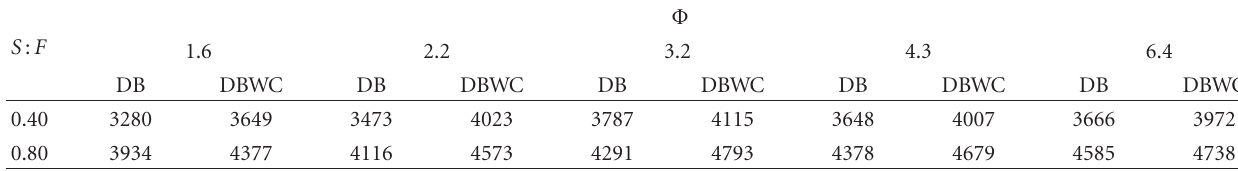
Table 3: Energy density of gases on a dry basis (kJ/SATPm 3 ) as a function of Φ and various S : F ratios for DB and DBWC, adapted from [11].